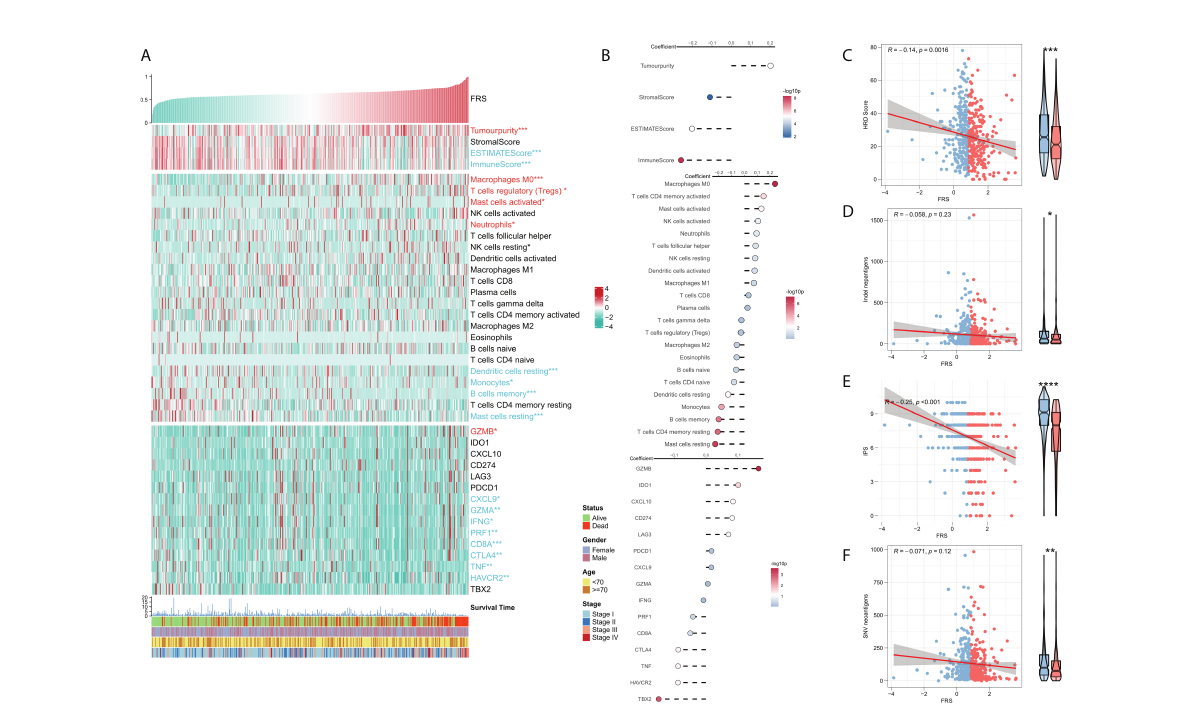
FIGURE 6 Immune in fi ltration analysis for FRS. (A) Heat map showing the correlation of FRS with the Estimate score, immune cell in fi ltration abundances, immune checkpoint expression, and clinical characteristics; (B) From top to bottom: correlational analysis of FRS with the Estimate score, immune cell in fi ltration abundances, and immune checkpoint expression. Scatter plot and box plot show the correlation of FRS with (C) HRD score; (D) Indel neoantigens; (E) IPS, and (F) SNV neoantigens. ” Red name with * represents upregulated in high-risk score group, and blue name with * represents upregulated in low- risk score group; *p < 0.05; **p < 0.01; ***p < 0.001; ****p <